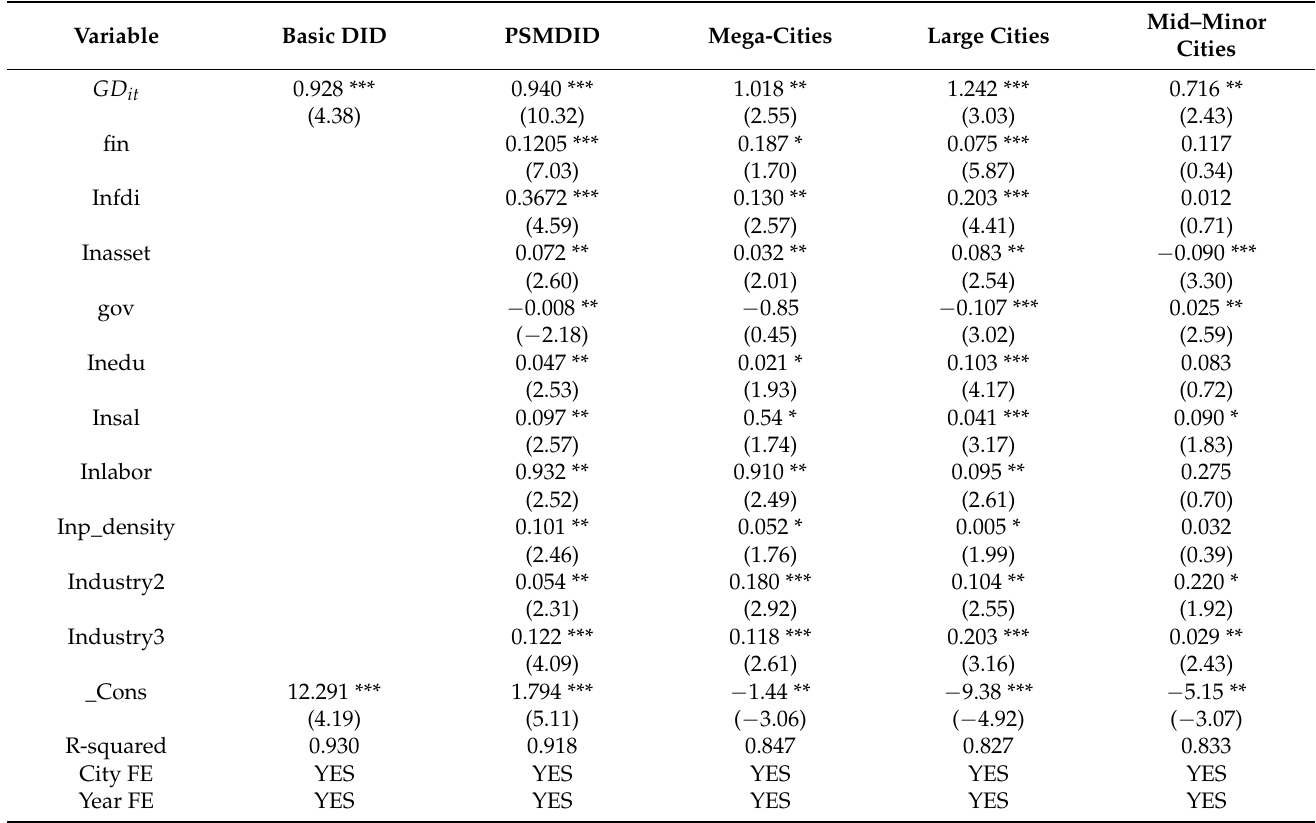
Table 5. Regression analysis of urban innovation dividend (capital